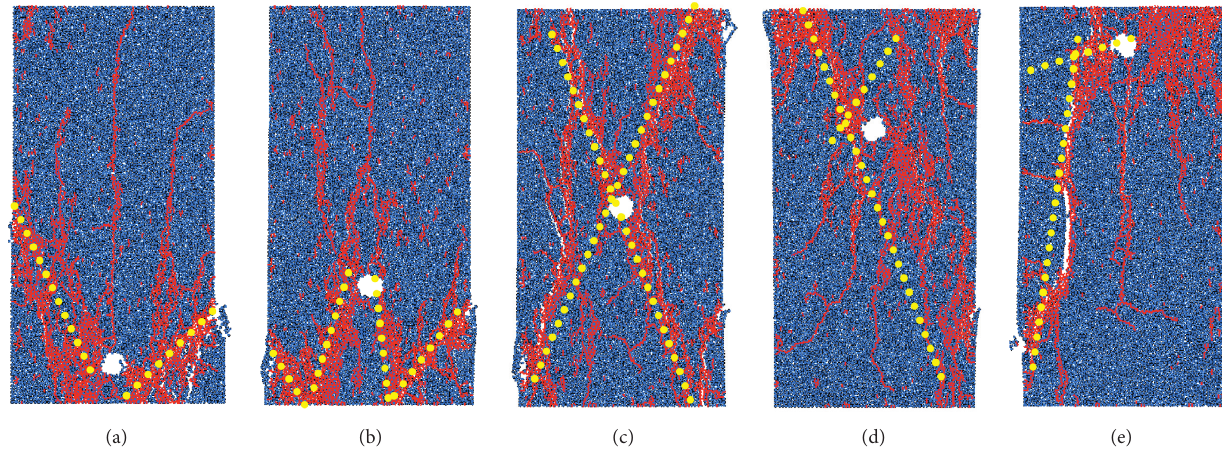
Figure 20: Failure modes of samples with different borehole height ratio. The R of (a), (b), (c), (d), and (e) are 0.1, 0.3, 0.5, 0.7, and 0.9, respectively.